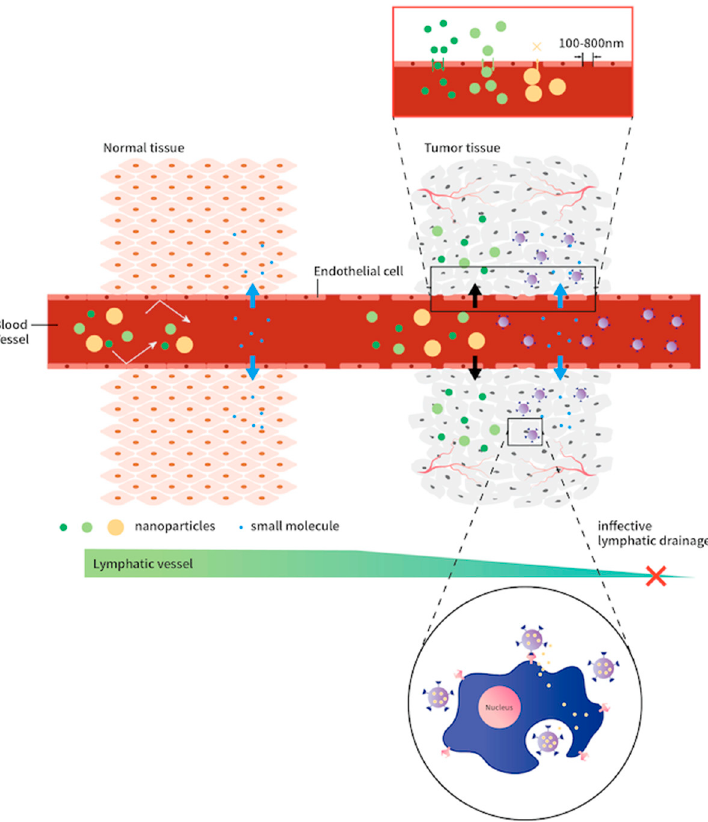
Figure 1. Normal tissue (left) and tumor tissue (right) have different sizes of microvascular endothelium intervals. The tumor tissue has larger microvascular endothelium intervals and allows nanomaterial through below of size of 200 nm. It is called the “enhance permeation and retention” (EPR) effect.